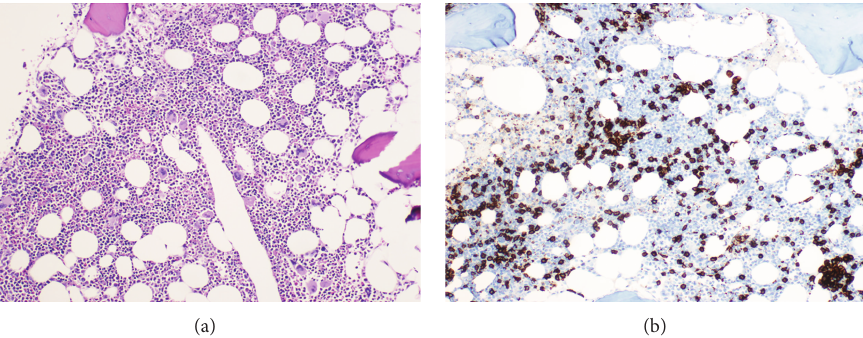
Figure 3: (a) Bone marrow biopsy shows a rather inconspicuous diffuse infiltrate of small mature lymphocytes (H&E × 200). (b) Immunohistochemical staining for CD20 reveals B-cell nature of the infiltrate. (Immunoperoxidase ×